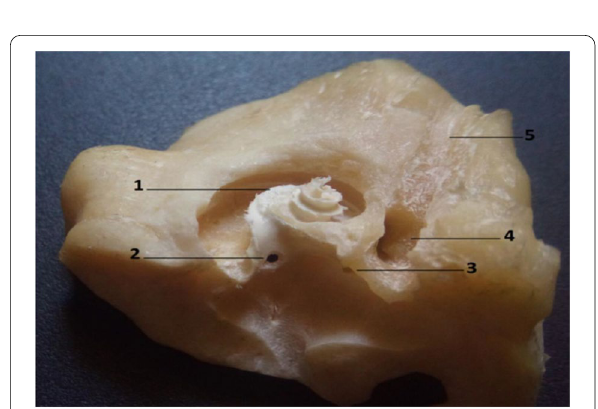
Fig. 6 Gross morphological image of bony specimen shows the middle ear side of inner ear after uncovering of the cochlea of the camel. 1. Cochlea, 2. Foramen for the saccular part of the vestibular nerve, 3. Foramen for utricle part of the vestibular nerve, 4. Facial canal, 5. Canal for greater petrosal nerve